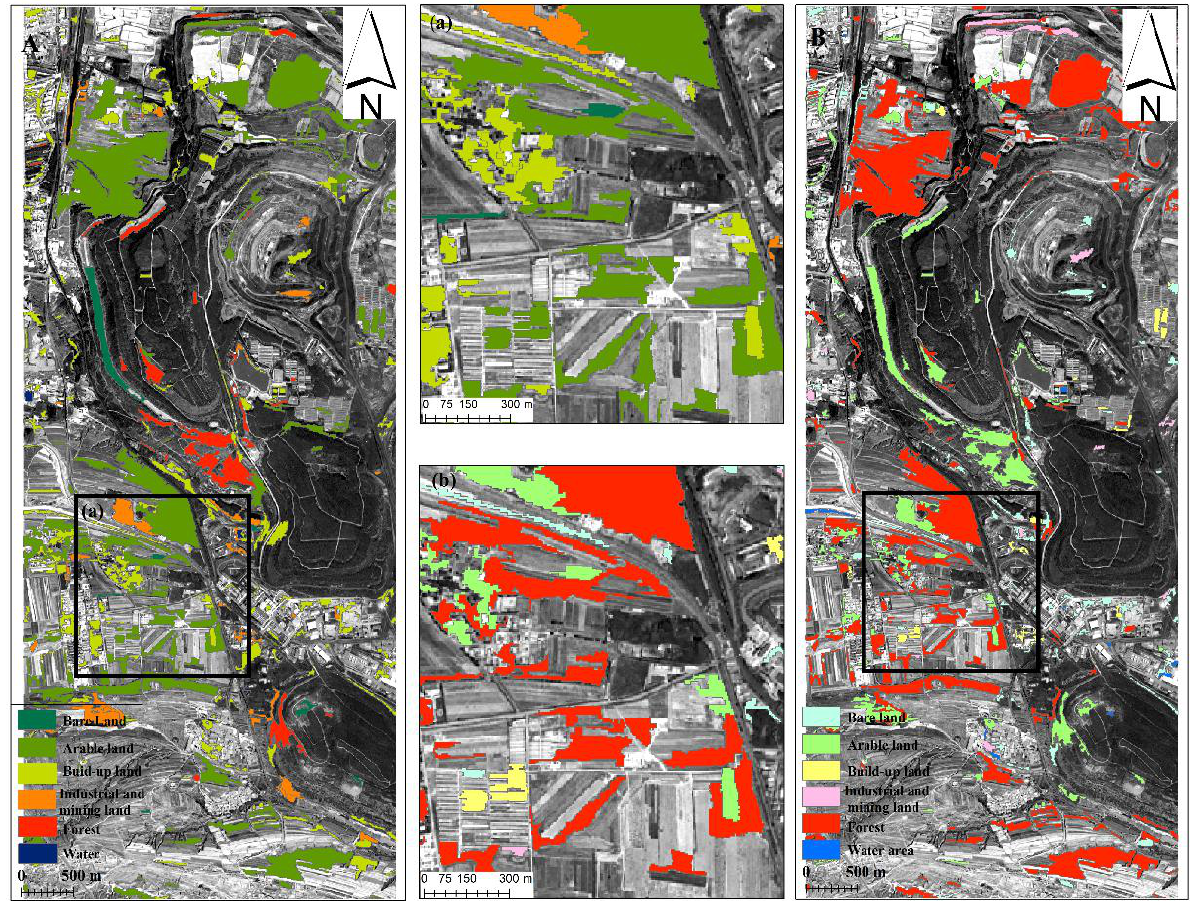
Figure 3. Panel A, the increased land cover class of Map 2015; panel B, the decreased land cover class of Map 2012